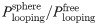
Effect of a confining sphere on the probability of looping.(A) Values of Ploopingsphere/Ploopingfree for various sphere sizes. (B) Values of F(L) for three of the smallest spheres compared to F(L) for the chain without a confining sphere.